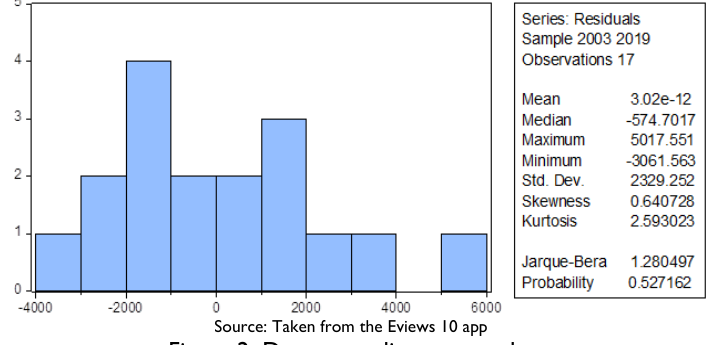
Source: Taken from the Eviews 10 app Figure 2. Data normality test